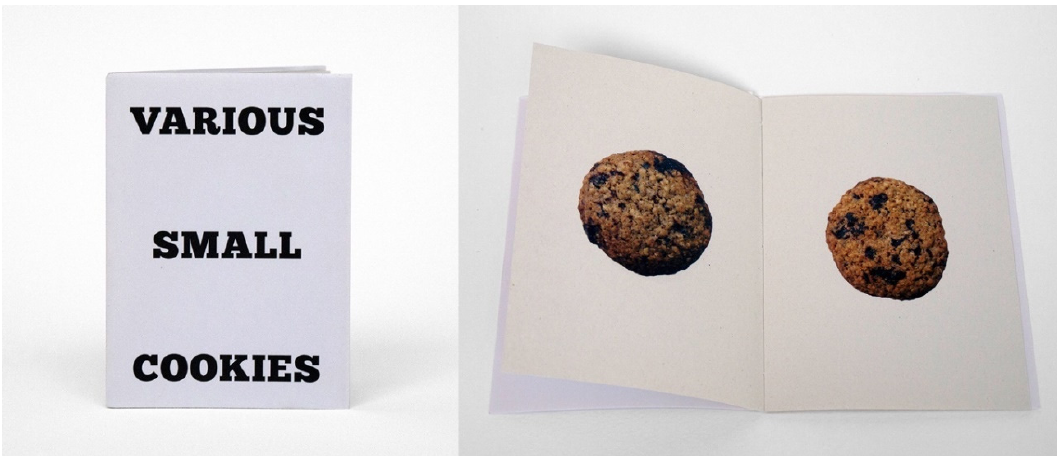
Figure 12. Simon Goode, Various Small Cookies , 2011.